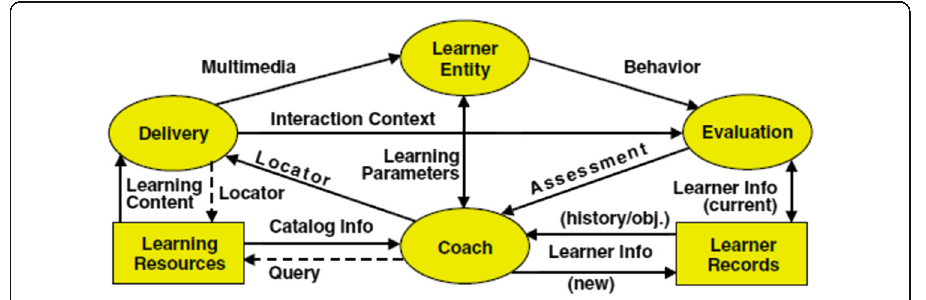
Fig. 9 LTSA system components (IEEE,